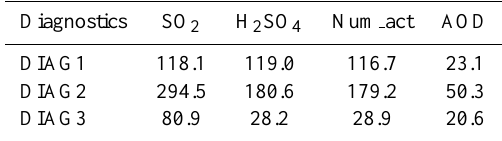
Table 1. Percentage mean (DJF mean) change in DIAG1, DIAG2 and DIAG3 for (a) SO 2 column burden (b) H 2 SO 4 column burden (c) vertically integrated number of activated particles (Num act) and (d) aerosol optical depth (AOD) at 0.55 µ m averaged over 30S-75S.